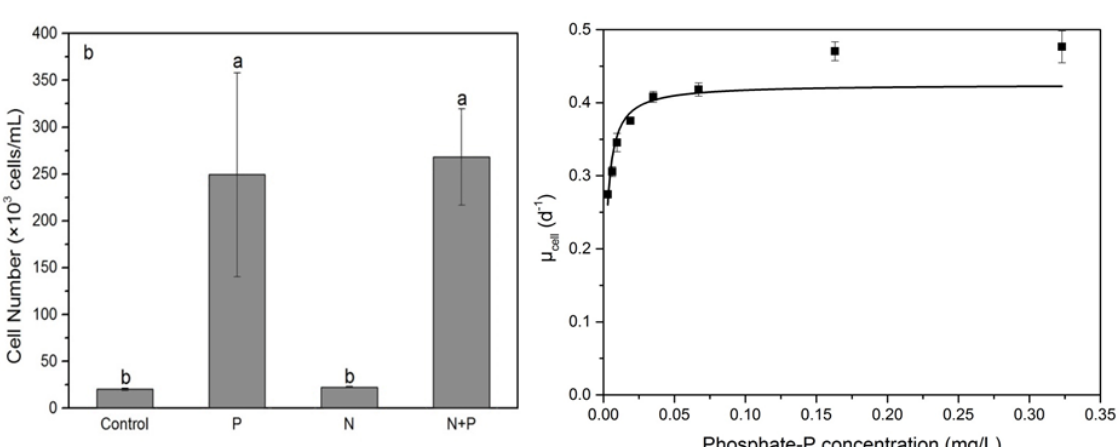
Figure A1.1 On the left, cell number at the end of the incubation experiments in samples with excess of phosphorus (P), nitrogen (N) and both (P+N). Bars are standard deviations, columns labelled with different letters are significantly different. On the right, estimated growth rates at different phosphate